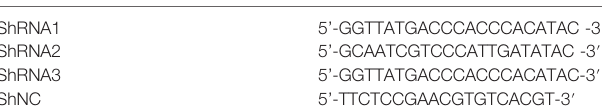
TABLE 1 | The Sequences of